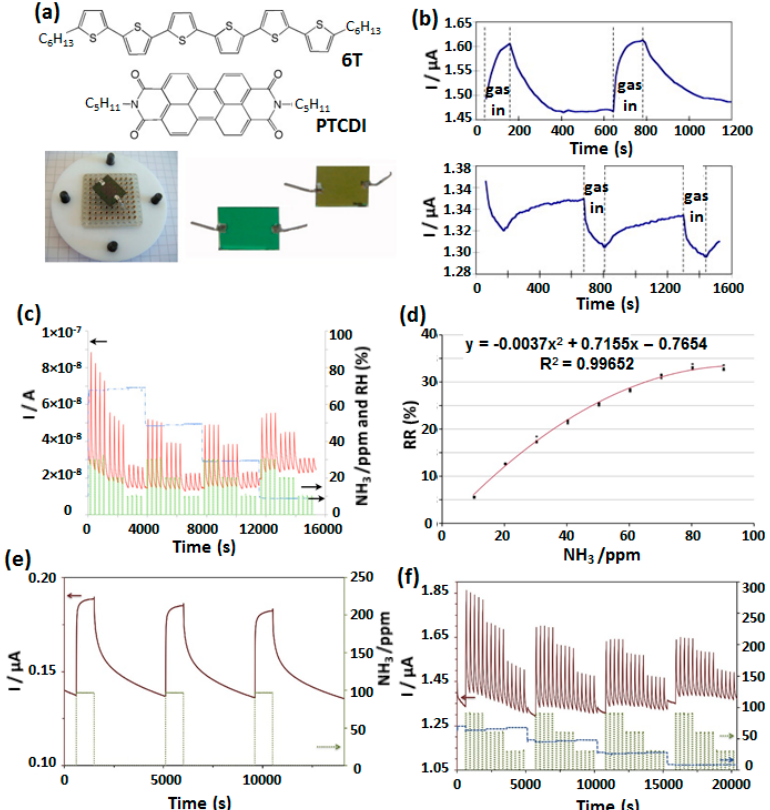
Figure 14. Structure of 5,5 ′ -dihexyl- α , ω -sexithiophene (6T) and the N,N ′ -dineopentyl-3,4,9,10- perylenetetracarboxylic-diimide (PTCDI) and optical image of the MSDI device ( a ) and its current variation under exposure to 400 ppb ozone (upper curve) and 200 ppm NH 3 (bottom curve) ( b ) [76]. Current variation of PTCDA-based MSDI at different NH 3 concentration (10, 20 and 30 ppm) and rh in the range of 30–70% ( c ) and sensor calibration curve depicting change in RR with NH 3 concentration ( d ) [77]. Current variations of n-MSDI based on TPDO sublayer and LuPc 2 top layer under 90 ppm NH 3 exposure for 15 min and recovery under clean air for 1 h ( e ). The sensor response at different NH 3 concentration (90, 60 30 ppm) and in the rh range of 10–70% ( f ) [78].